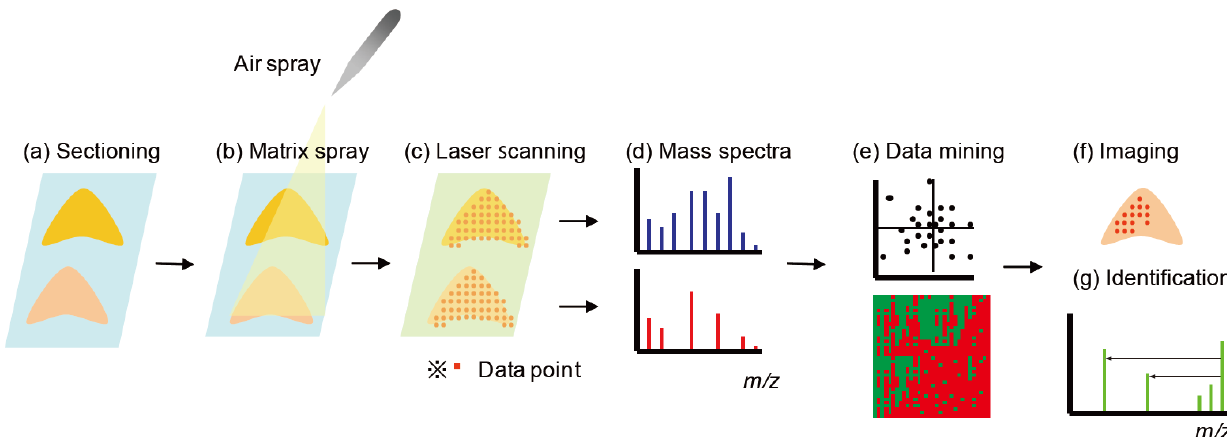
Figure 1. Schema of biomarker discovery using MALDI-IMS. Thin-section samples are mounted on a plate ( a ), coated with matrix ( b ), and measured by a mass spectrometer ( c ). Obtained mass spectra ( d ) are used for a data mining approach ( e ). Molecules of interest can be visualized ( f ) and identified by MS/MS of tissues ( g